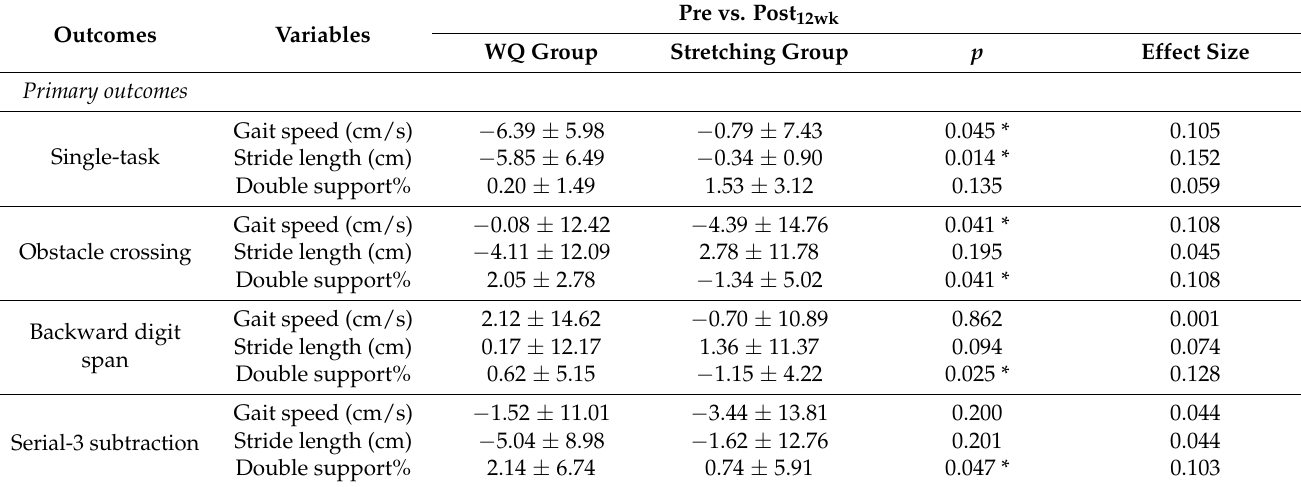
Table 3. Between-group comparisons of changes from baseline for clinical